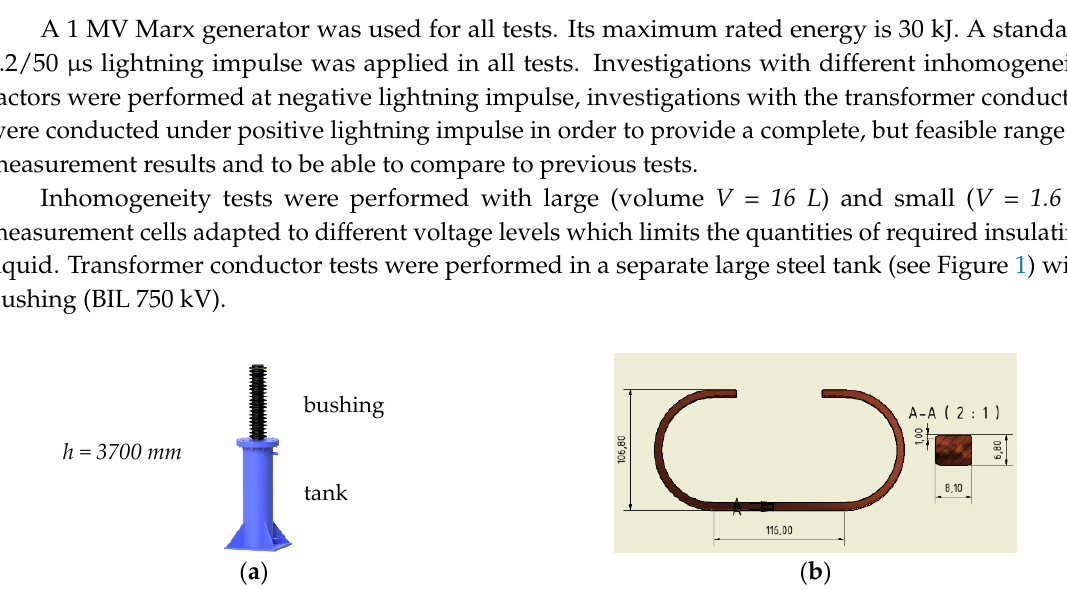
Table 1. Configurations for inhomogeneity tests under lightning impulse (LI) at negative polarity.